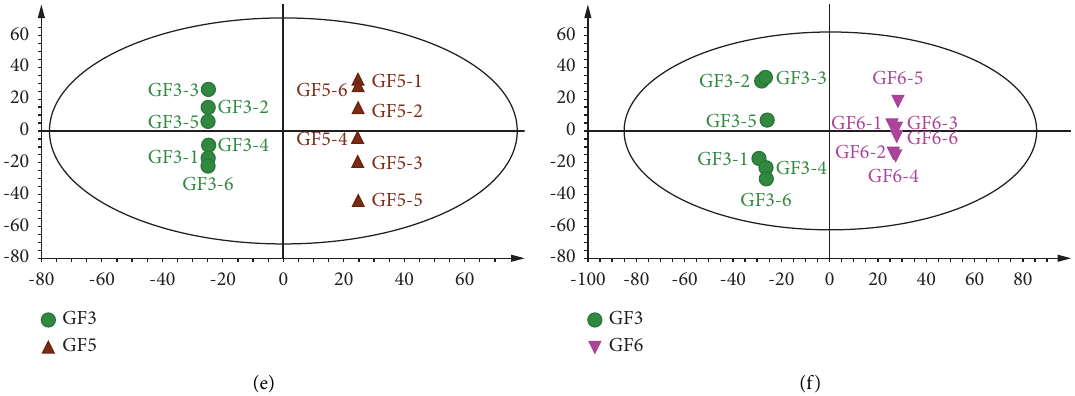
Figure 2: Score plots of PCA analysis (a)–(c). OPLS-DA analysis (d)–(f) of GF3 vs. GF4, GF3 vs. GF5, and GF3 vs. GF6. PCA: principal component; OPLS-DA: orthogonal partial least squares-discriminant analysis. For GF3 vs. GF4, R 2 X is 0.753, R 2 Y is 1, and Q 2 is 0.795; for GF3 vs. GF5, R 2 X is 0.787, R 2 Y is 1, and Q 2 is 0.924; for GF3 vs. GF4, R 2 X is 0.570, R 2 Y is 0.998, and Q 2 is 0.892.